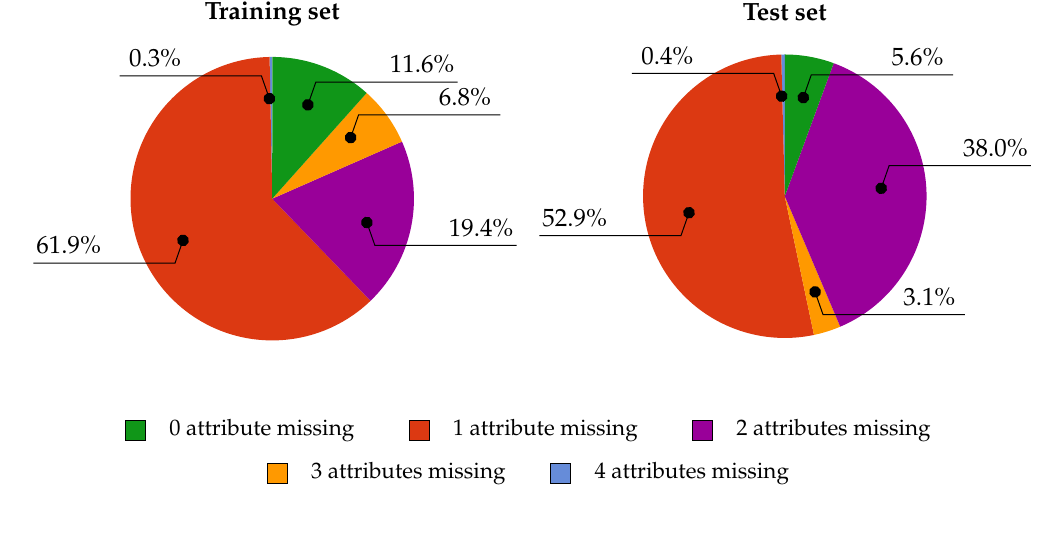
Figure 4. The percentage of missing attributes in training and test